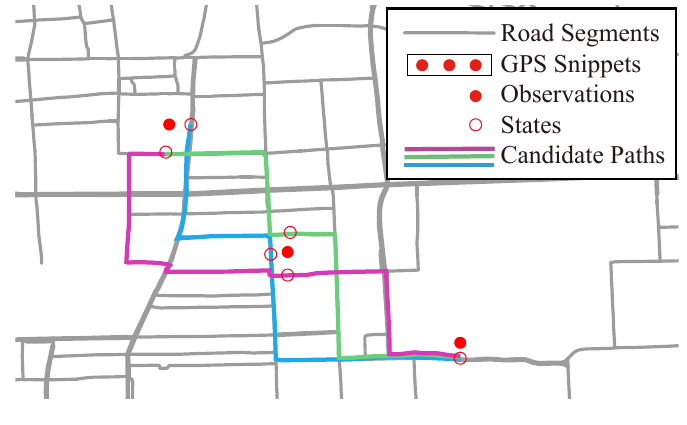
Figure 2. Concepts on path